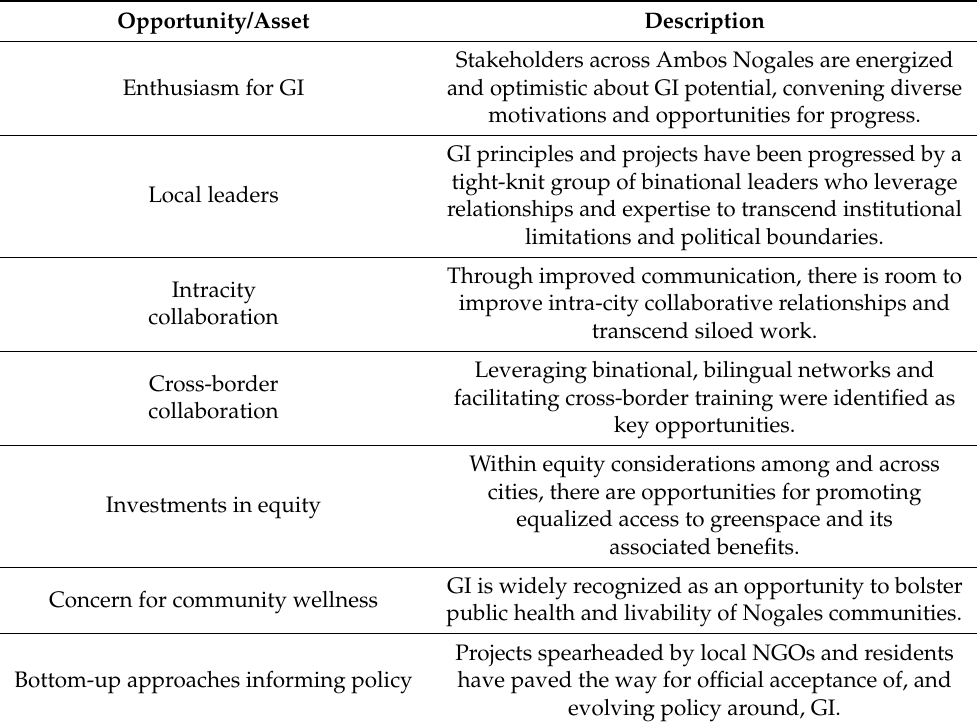
Table 6. Opportunities for GI adoption in Ambos Nogales